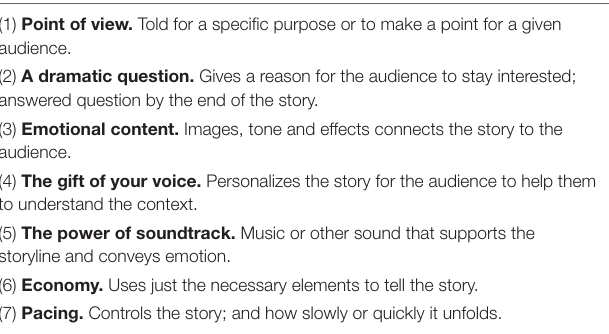
TABLE 1 | Seven elements of digital